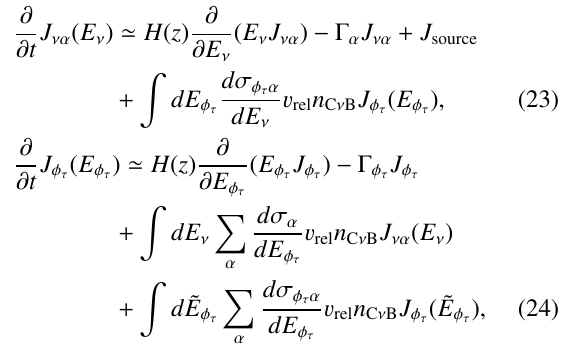
Figure 7. The predicted fluxes of neutrinos (black solid line) and dark matter (red solid line). m φ = 0 . 5 are ˜ y τ U τ | |